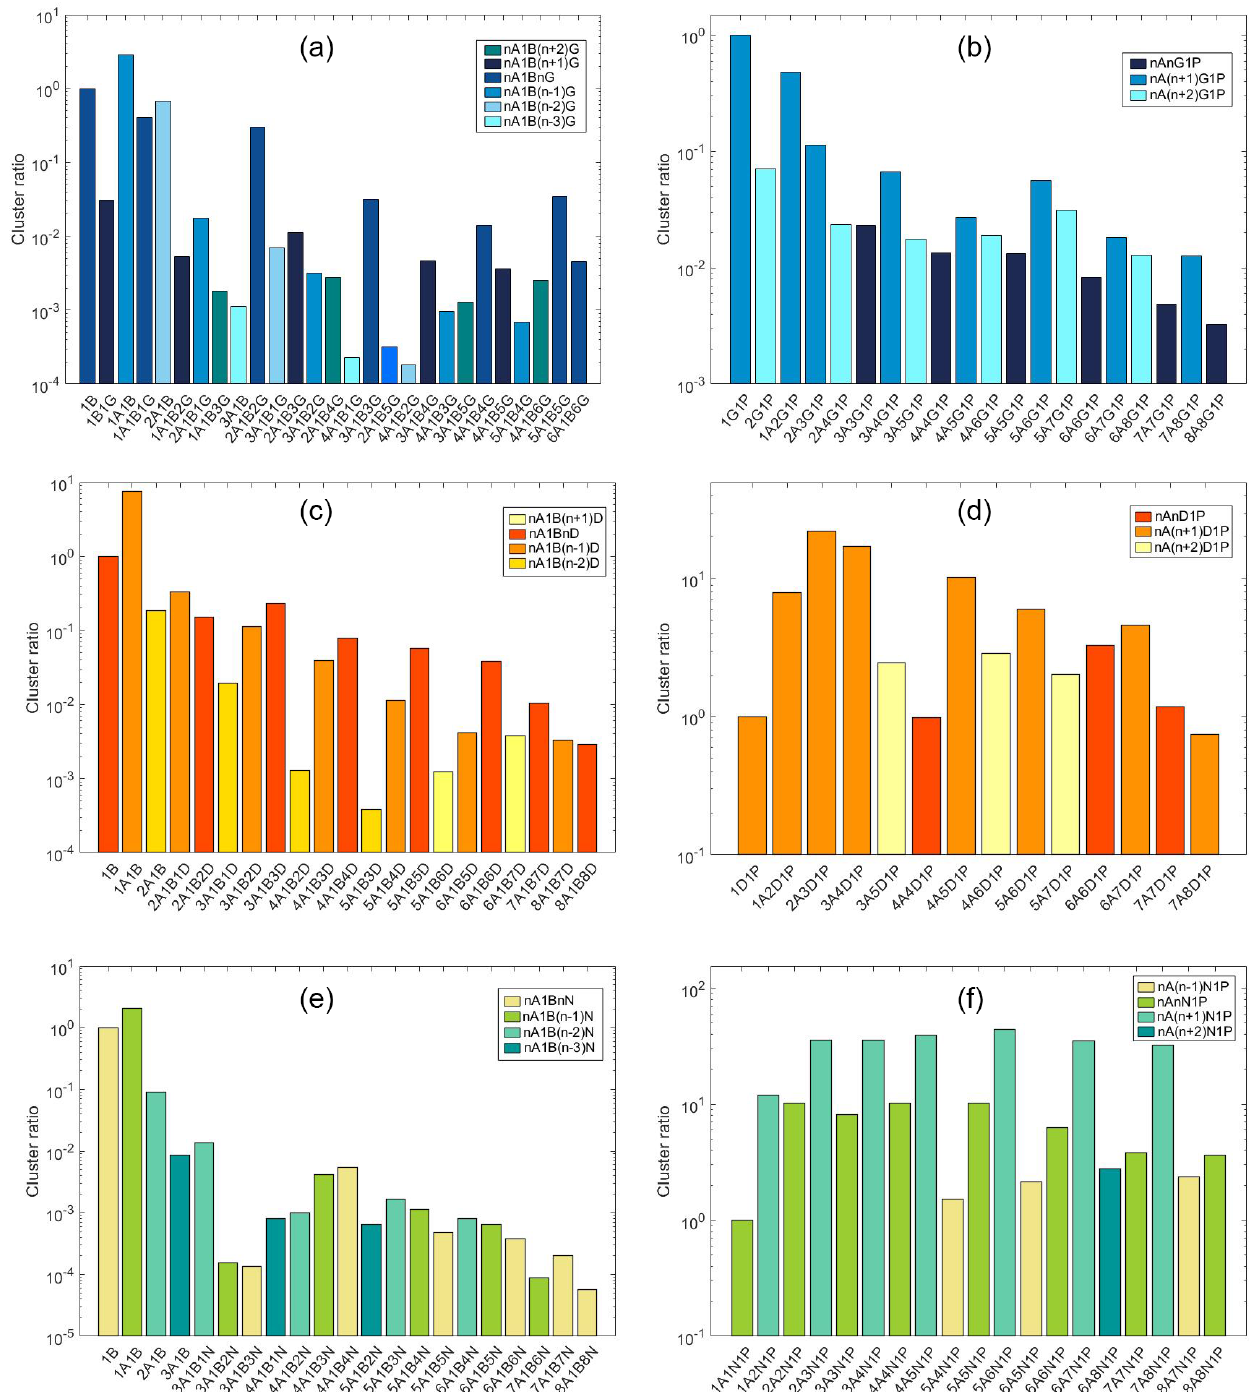
Figure 8. Experimentally determined relative cluster concentrations in negative (a, c, e) and positive (b, d, f) modes for sulfuric acid with guanidine (a, b) , dimethylamine (c, d) and ammonia (e, f)